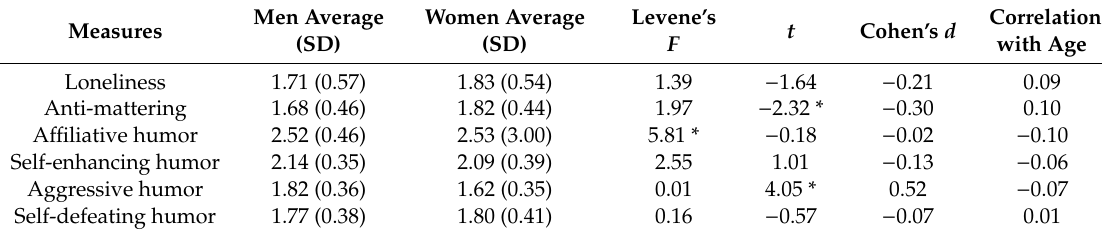
Table 1. Descriptive statistics and independent samples t